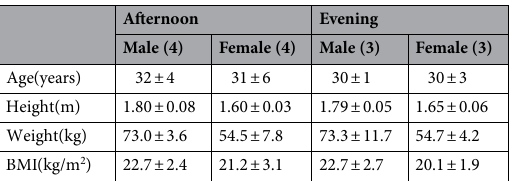
Table 1. Anthropometric characteristics (mean ± SD) of the